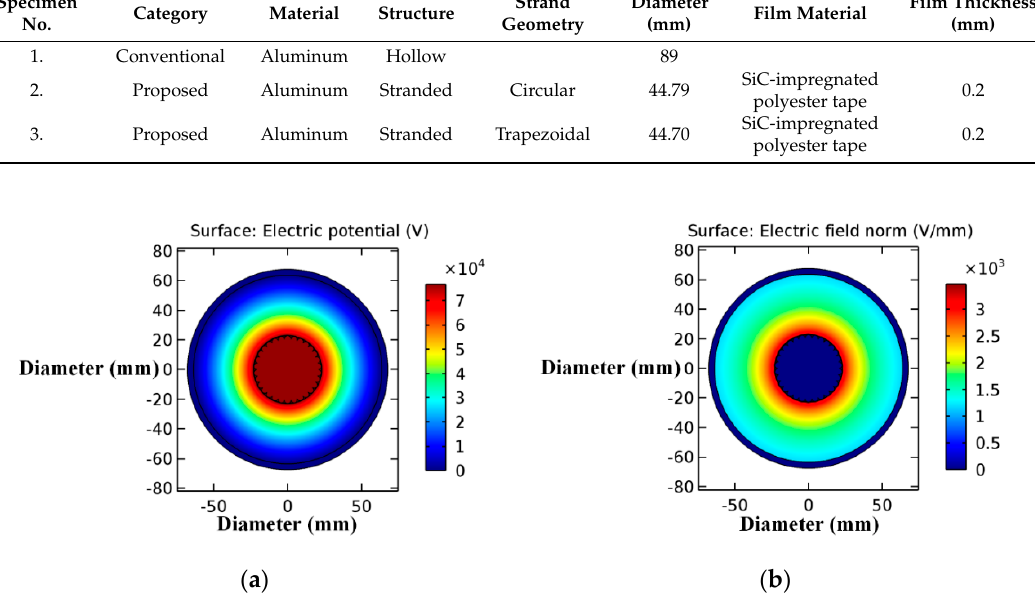
Figure 8. ( a ) Potential difference and ( b ) field distribution apropos of the proposed pliable GIL regarding specimen 2 of Table 3.